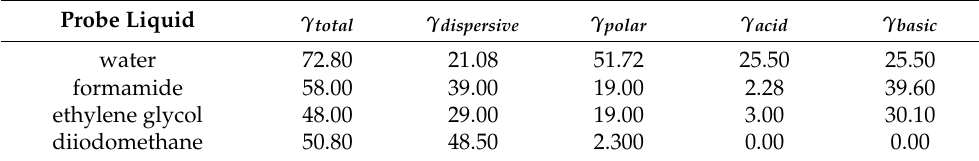
Table 1. Surface tension ( γ ) of probe liquids for surface energy